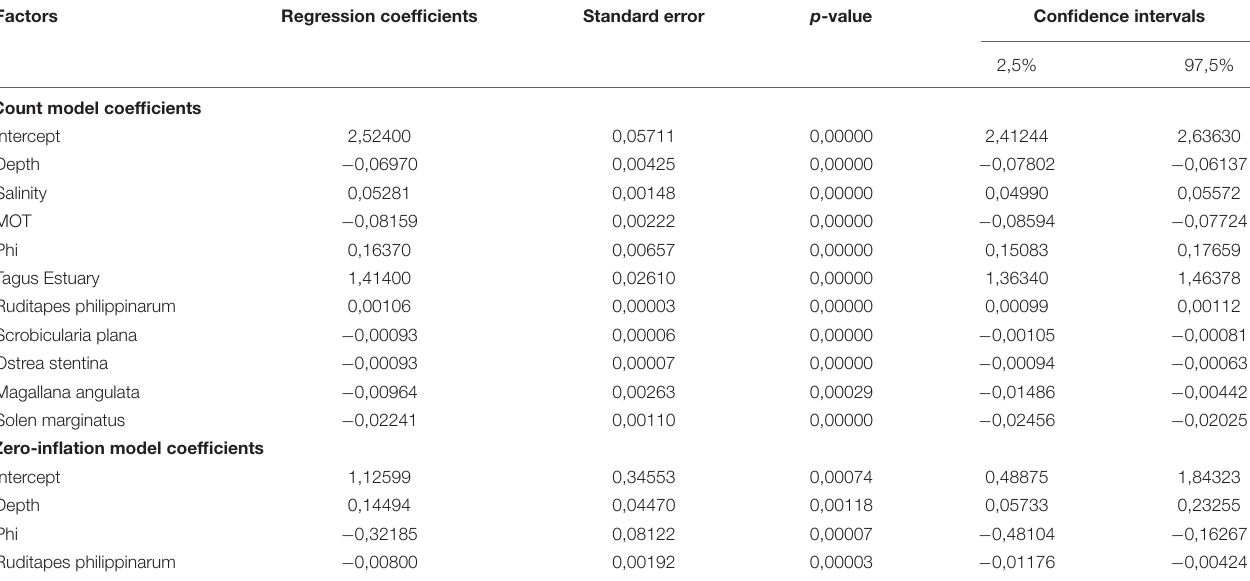
TABLE 2 | Characterization of the explanatory environmental factors selected as integrating the final model explaining cockle distribution in the Tagus and Sado estuaries.